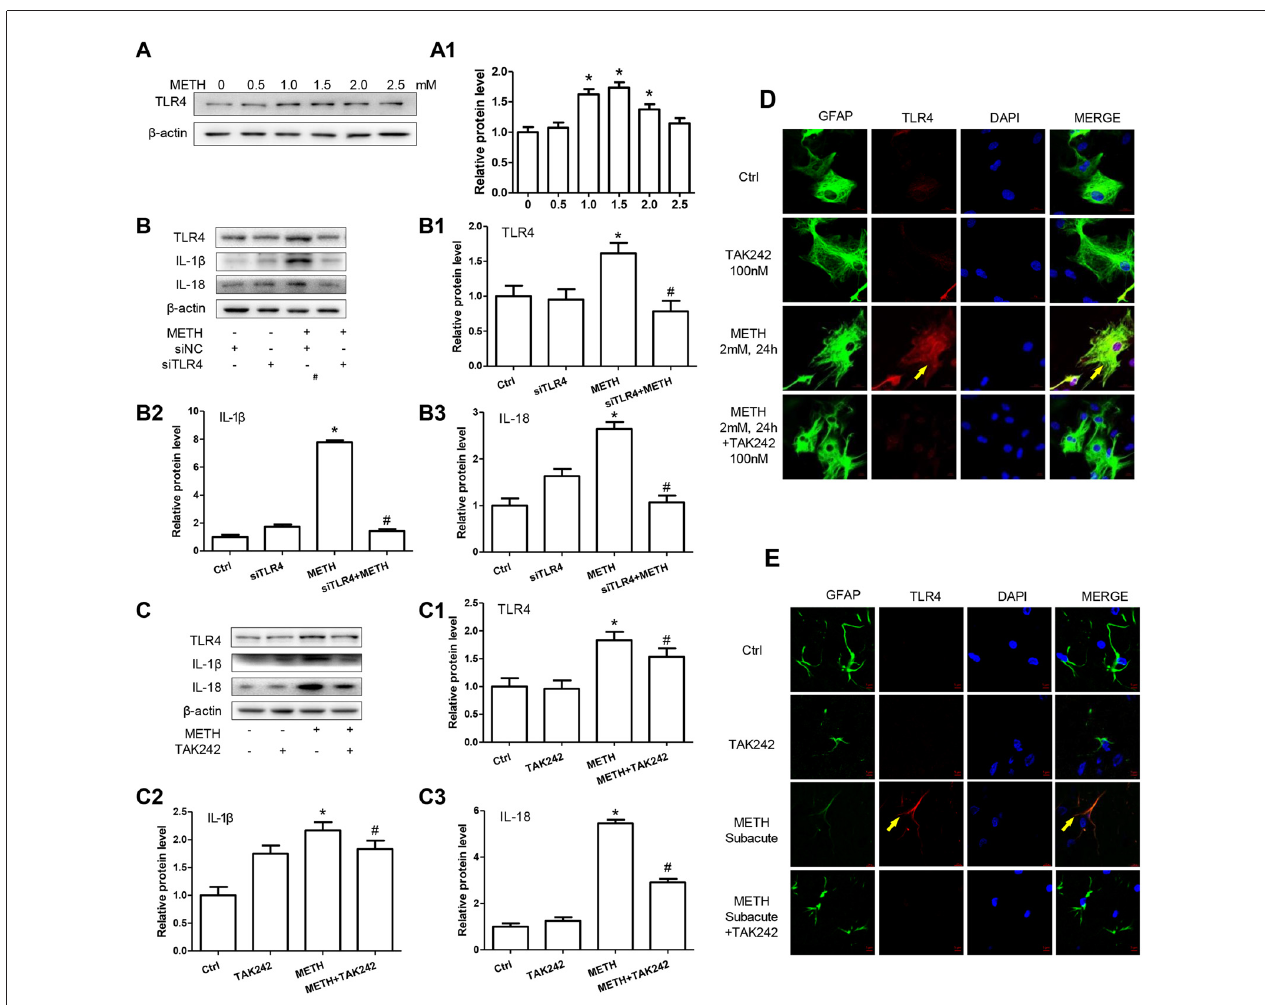
FIGURE 4 | Toll-like receptor 4 (TLR4) is necessary for METH-induced IL-1 β and IL-18 expression in astrocytes. (A,A1) Primary cultured astrocytes were exposed to 0.5, 1.0, 1.5, 2.0 and 2.5 mM METH for 24 h. (B–B3) Cells were transfected with siRNAs targeting TLR4 or control siRNA for 24 h followed by METH (2 mM) treatment for 24 h. (C–C3,D) Cells were exposed to TAK-242 (100 nM) for 2 h prior to METH (2 mM) treatment. Western blot (A–C) and quantitative analyses were performed to determine TLR4, IL-1 β and IL-18 protein expression. Immunolabeling and confocal imaging analysis (D) showed elevated TLR4 expression in the cells treated with METH compared with controls. (E) Male C57BL/6 mice were divided randomly into control, METH, TAK-242 and METH + TAK-242 groups ( n = 3/group). TAK-242 was injected intraperitoneally with DMSO and saline (3 mg/kg/injection, five injections, at 24 h intervals). At the 2nd day, animals were injected intraperitoneally with saline or METH (15 mg/kg/injection, eight injections, at 12 h intervals). Midbrain tissues were harvested at 2 h after the last dosing. Immunolabeling and confocal imaging analysis showed elevated TLR4 expression in the midbrain of METH-exposed mice compared with controls. Yellow arrow refers to TLR4. Cell experiments were repeated three times. Data are expressed as mean ± SD. ∗ p < 0.05 vs. non-METH-treated group. # p < 0.05 vs. the scrambled + METH treated group. Data in (A) were analyzed with one-way ANOVA followed by LSD post hoc analyses; data in (B,C) were analyzed with 2 × 2 factorial ANOVA followed by LSD post hoc